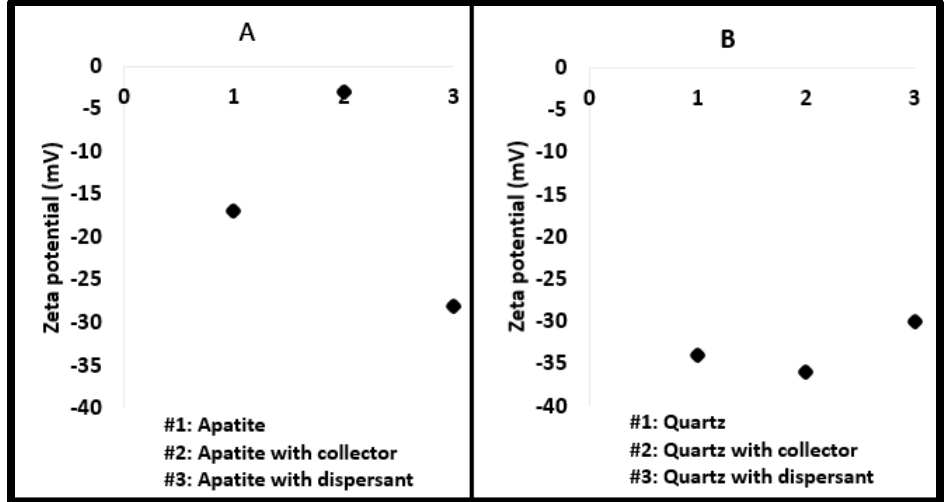
Figure 6. Zeta potential of apatite and quartz dispersions as a function of pH.